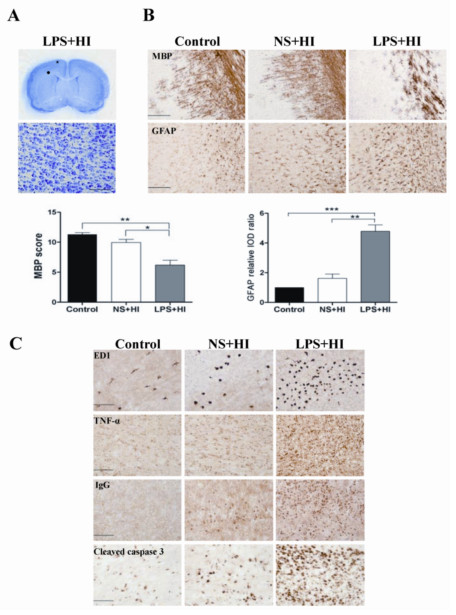
Upregulation of neuroinflammation, blood–brain barrier damage and cell apoptosis in association with white matter injury in P2 rat pups after lipopolysaccharide-sensitized hypoxic-ischemia. On P11 in the LPS + HI group, Nissl staining (A) showed no significant injury in the cortex (gross picture in the upper panel; microscopic picture in the lower panel photographed from the cortex marked with an asterisk). (B) Immunohistochemical staining demonstrated that the LPS + HI group had markedly decreased MBP expression and increased GFAP-positive astrogliosis in the white matter of the ipsilateral hemisphere compared to the control and NS + HI groups. (C) Immunohistochemistry 24 h post-insult showed that the LPS + HI but not the NS + HI group had significant increases in ED1-positive microglia, TNF-α immunoreactivities, IgG extravasation, and cleaved caspase 3-positive apoptotic cells in the white matter. Microscopic pictures of (B,C) were taken from the white matter area marked with a circle in (A). ED1, microglia marker; GFAP, glial fibrillary acidic protein; HI, hypoxic-ischemia; LPS, lipopolysaccharide; MBP, myelin basic protein; NS, normal saline; P, postpartum. Scale bar = 200 μm for MBP, 50 μm for cleaved caspase 3, and 100 μm for the others.